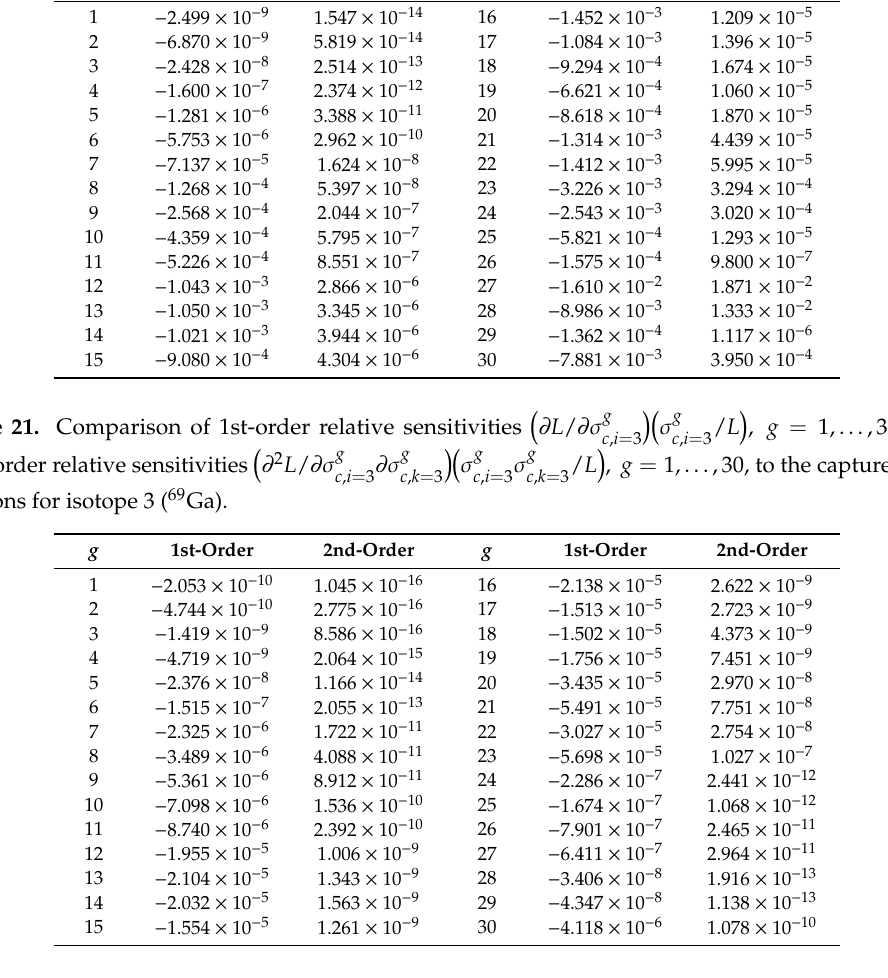
(cid:16) (cid:17)(cid:16) (cid:17) ∂ L / ∂σ g σ g / L , g = 1, ... ,30, c , i = 4 c , i = 4 (cid:16) (cid:17)(cid:16) (cid:17) ∂ 2 L / ∂σ g ∂σ g σ g σ g / L , g = 1, ... ,30, to the capture c , i = 4 c , i = 4 c , k = 4 c , k = 4